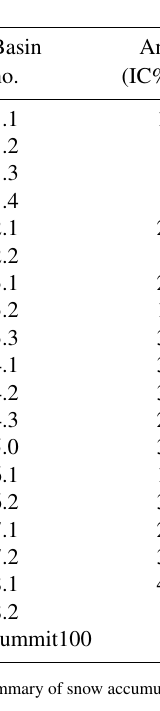
Table 2. Summary of 2CSP accumulation estimates by GrIS basin. All masses are in Gtyr − 1 . The “summit100’ basin includes every observation within 100km of Summit